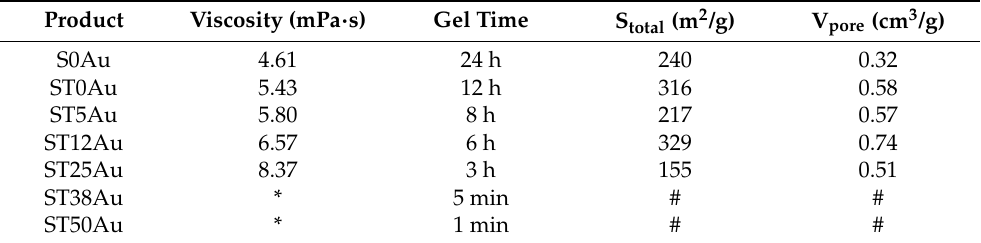
* Fast gelation, measurement impossible # material not